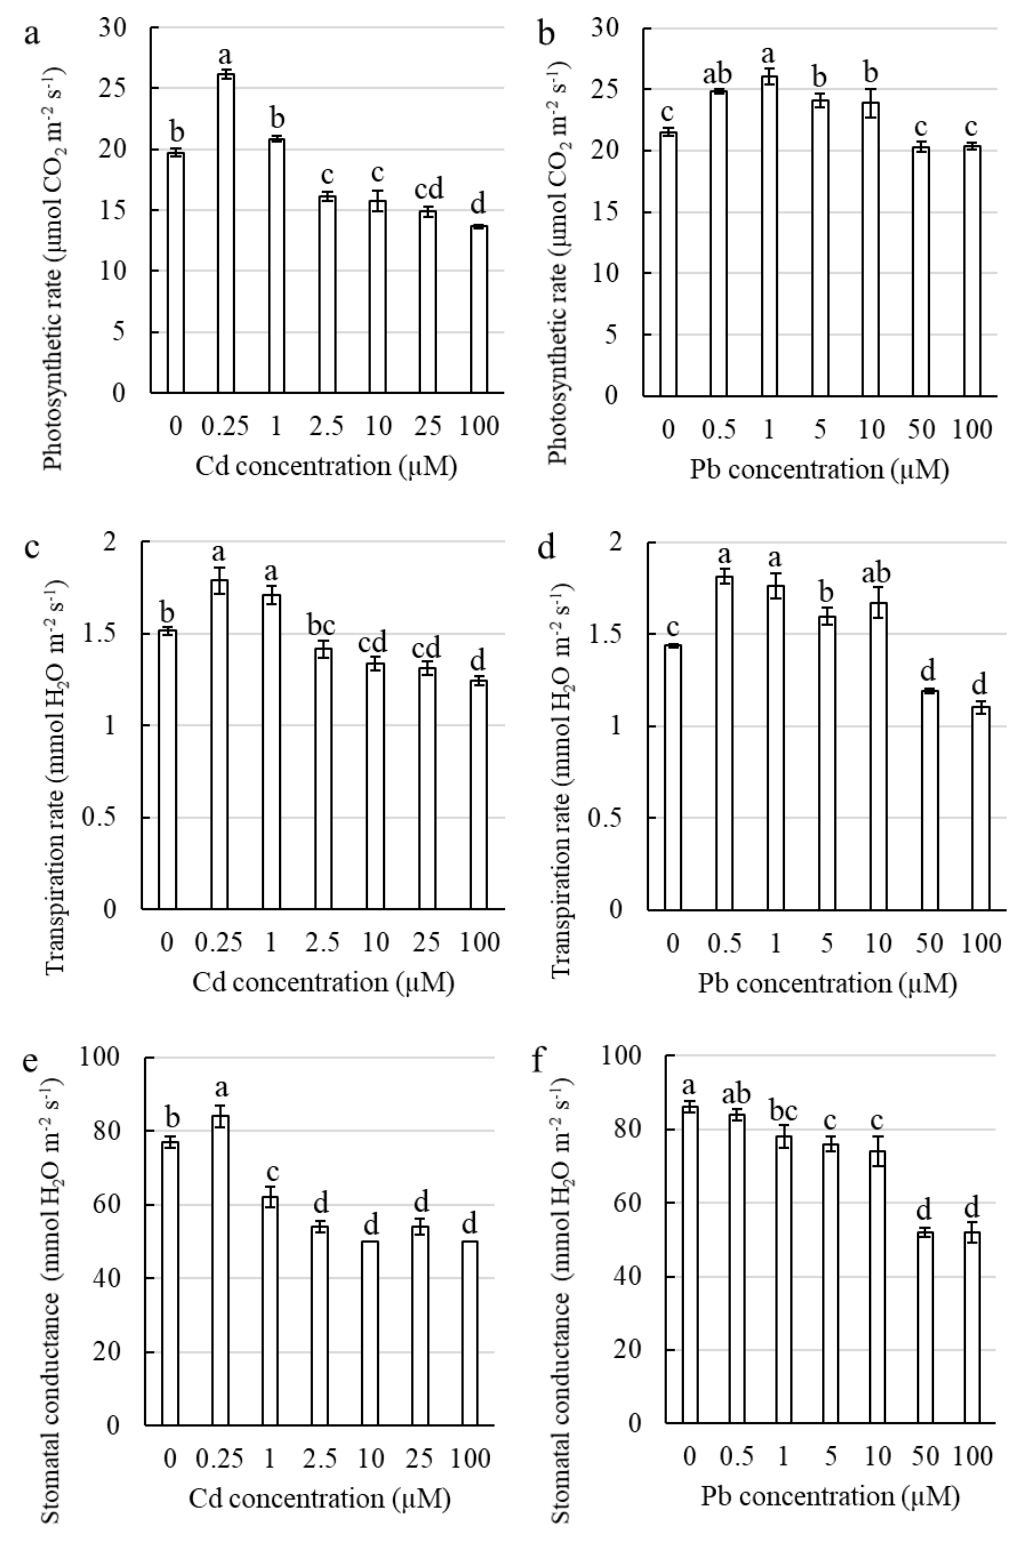
Figure 7. The effect of Cd and Pb on the photosynthetic and transpiration rate and stomatal conductance in the corn leaves. Cd ( a , c , e ) and Pb ( b , d , f ). The values are the means ± SE ( n = 15). Means followed by the same letter are not significantly different from each other using LSD test ( p < 0.05).